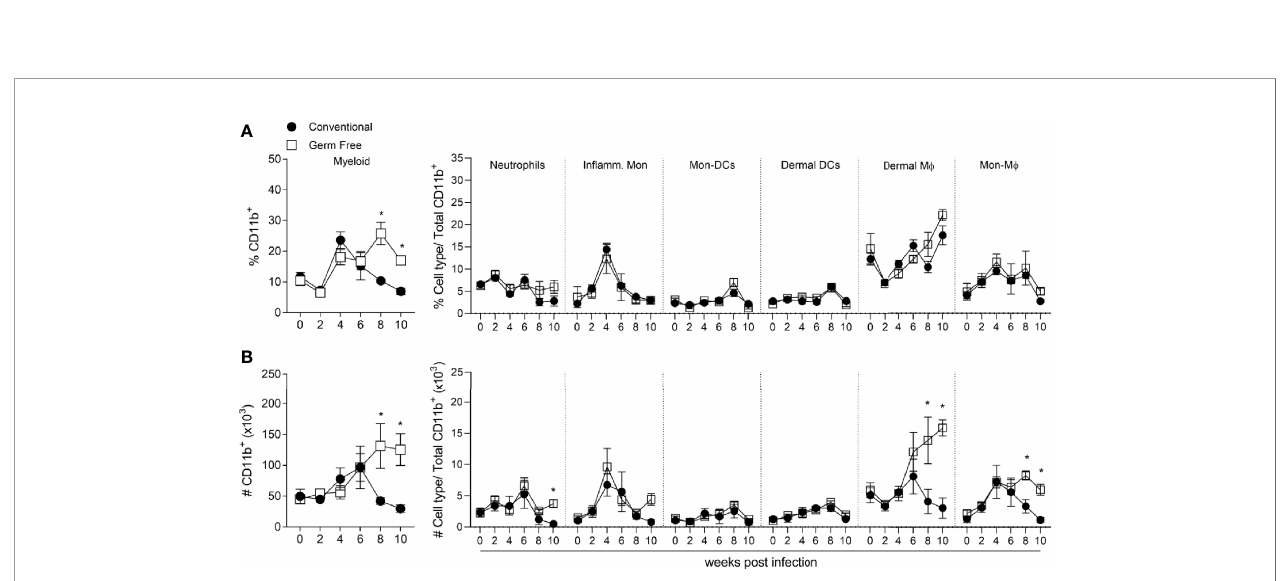
FIGURE 3 | Germ-free mice showed higher number of myeloid cells at late infection time points. (A) Percentage of myeloid cells subsets in the footpad of uninfected and L. major infected mice, 2-10 weeks after infection. (B) Absolute number (#) of myeloid cells subsets in the footpad of uninfected and L. major infected mice, 2-10 weeks after infection. * indicates statistical difference between groups of mice using two-way ANOVA and Bonferroni post-test (p < 0.05). Results are representative of two independent experiments. Four to 6 animals per group were used per time.